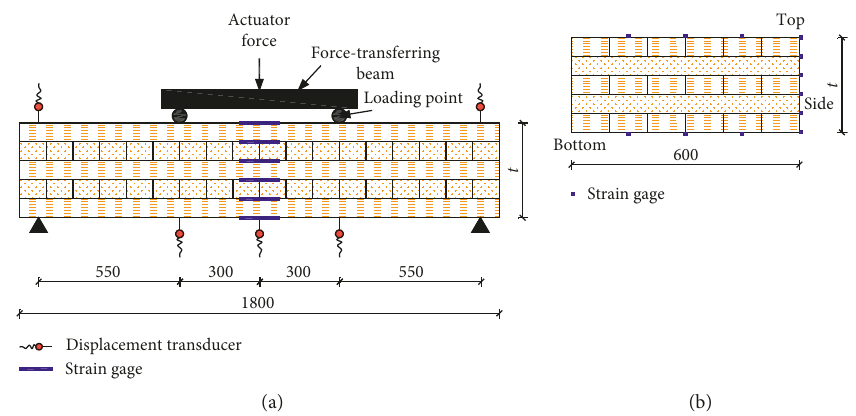
Figure 13: Layout of measurement equipment. (a) Side face. (b) Top or bottom face.